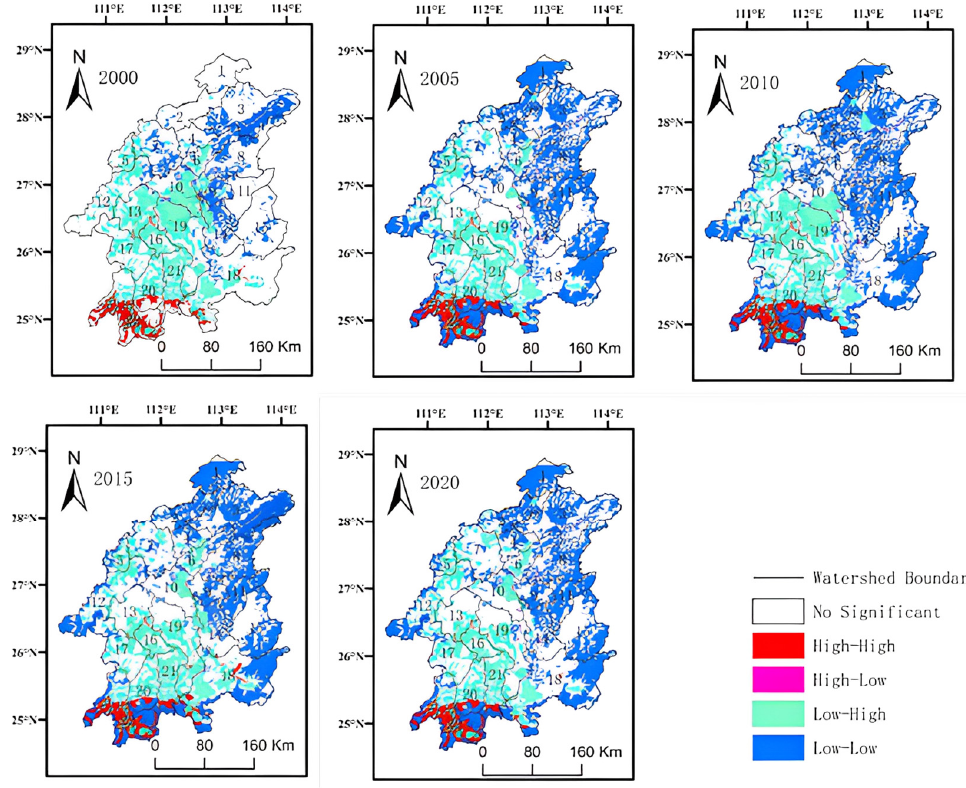
Figure 7. LISA cluster map of water yields in the XRB from 2006 to 2020.